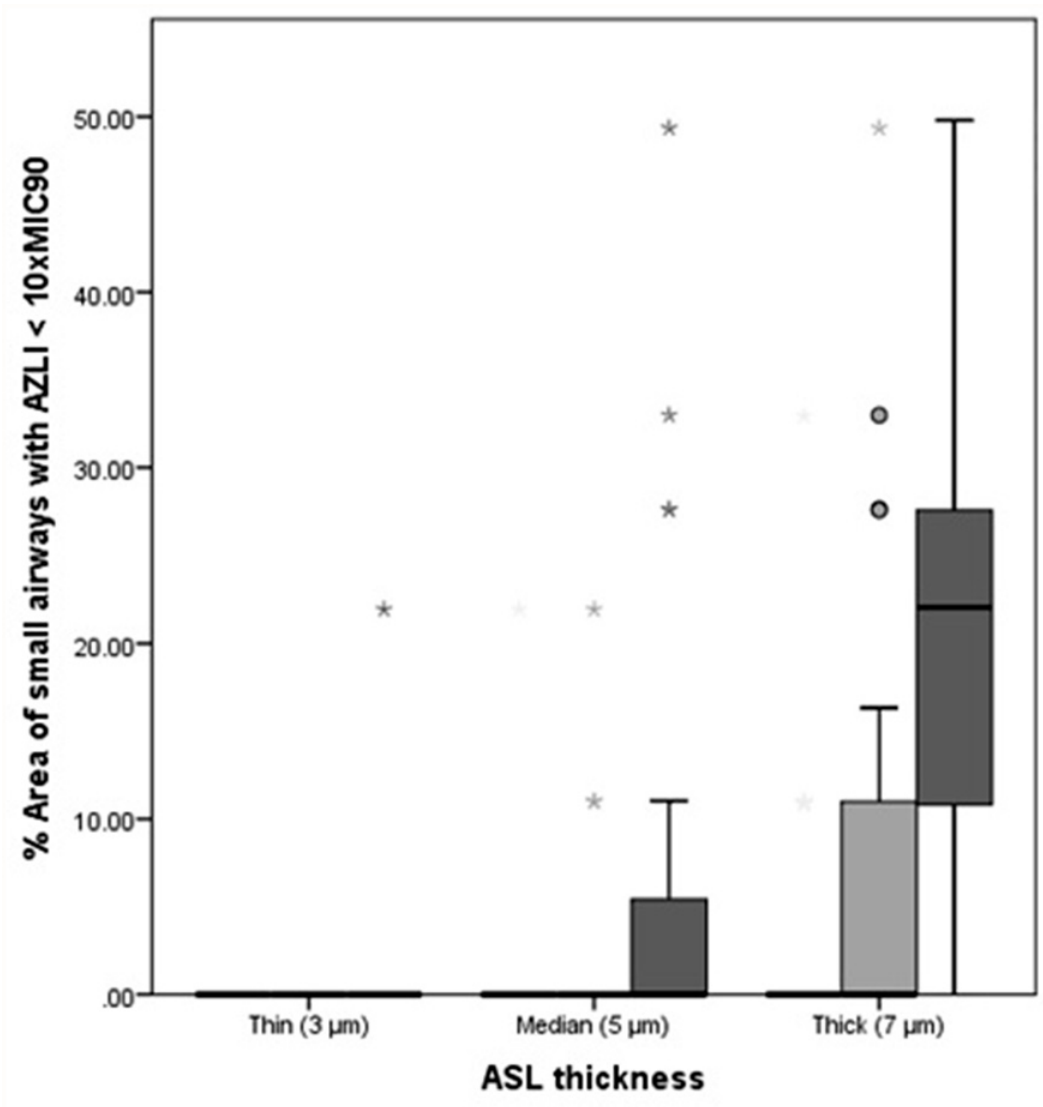
Fig 4. Percentage area of small airways with AZLI < 10xMIC 90 . Percentage area of small airways with AZLI concentrations < 10xMIC 90 . Data are presented as median (range) for the different scenarios. White bars represent the smallest aerosol diameter (2.9 μ m), light grey bars represent the median aerosol diameter (3.18 μ m) and dark grey bars represent the largest aerosol diameter (4.35 μ m). ASL = airway surface